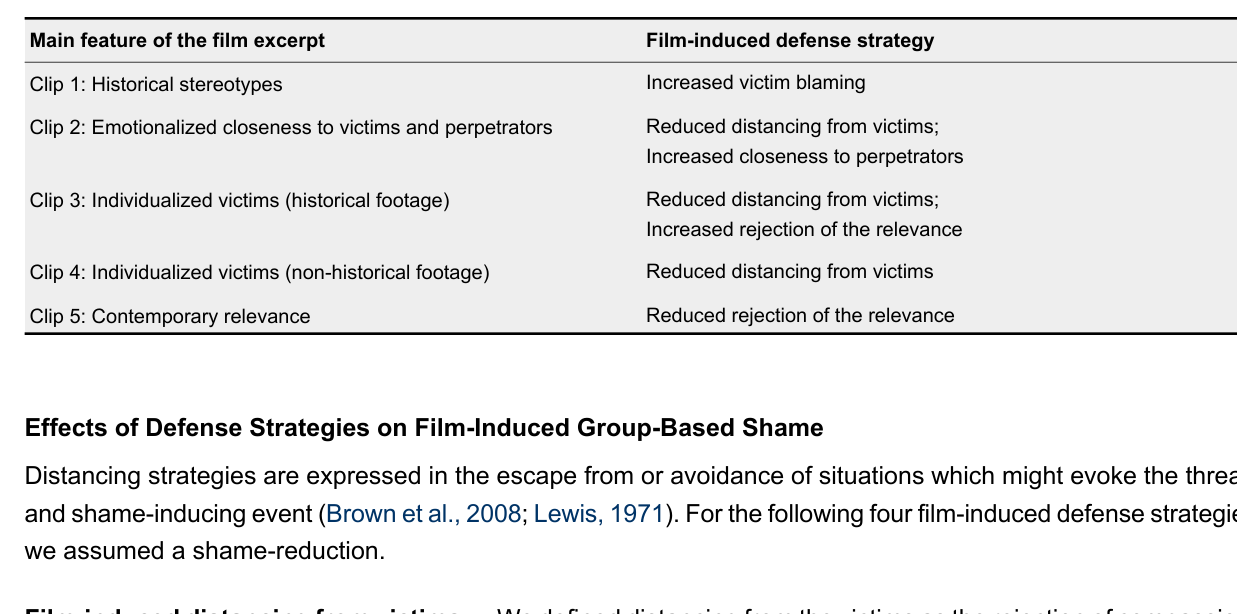
Hypothesized Effects of Film Excerpts on Film-Induced Defensiveness Strategies